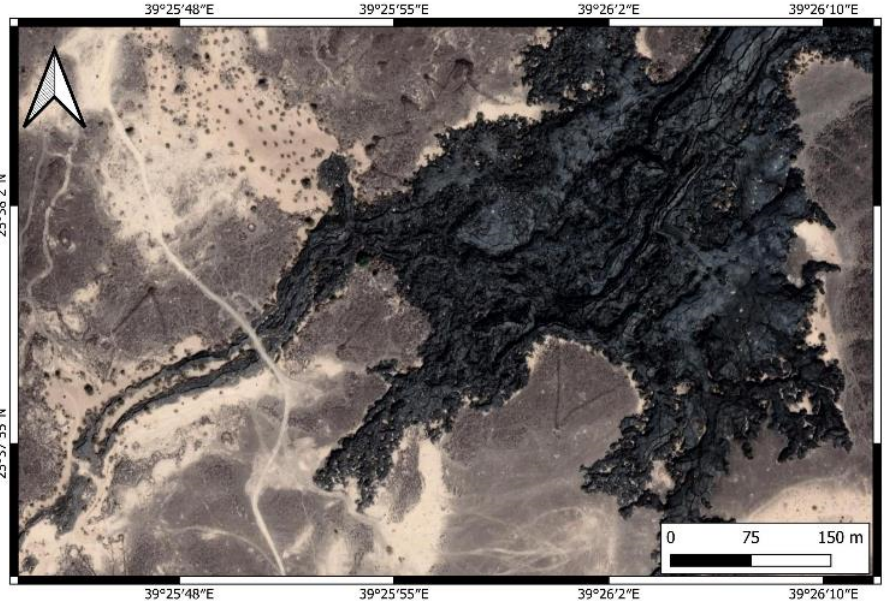
Figure 17. Two desert kites closely facing toward the terminal zones of young lava flows are unlikely places to set up game traps as the rugged surfaced lava flow is not a place where animal migration is expected. This is indirect evidence that the lava flow was emplaced after the desert kites were constructed.